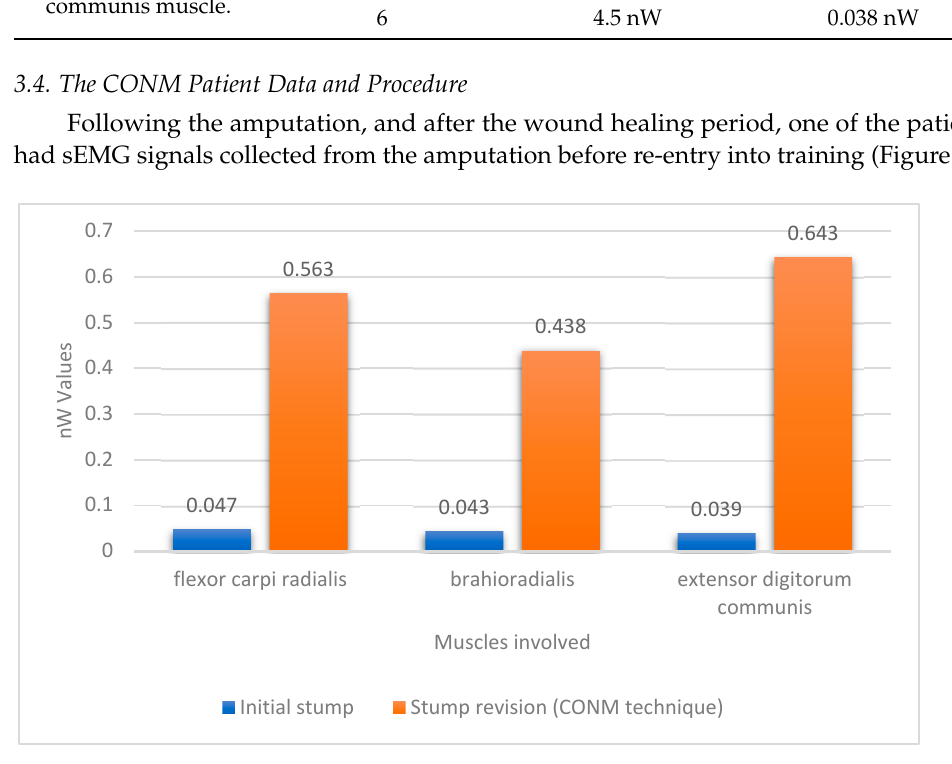
Figure 5. The CONM surgical technique with partial excision of the forearm fascia together with a reduction in the subcutaneous fat layer and re-disposition of the individual muscles. As required by the CONM technique, a preoperative radiological study was per- formed to thoroughly evaluate the level of the needed bone spur ostectomy and radial and ulnar osteotomy. The stump was revised by a subcutaneous dissection and formed two flaps and visualization of the antebrachial fascia, which was later partially removed, together with approximately 20–30% of the subcutaneous fat, in a circumferential manner. Each muscle and each nerve was individually dissected and identified, while the radius and ulna were trimmed of bone spurs and shortening osteotomy was performed on each of them. The next step involved drilling transosseous holes to anchor the individual mus- cles. Each individually dissected muscle was brought in the same plane and sutured to the radius and ulna, while the three nerves were transposed superficially. A single layer suture was performed, followed by a sterile dressing and a post-operative X-ray to eval- uate the new resection level of the forearm bones. The healing period was uneventful, and